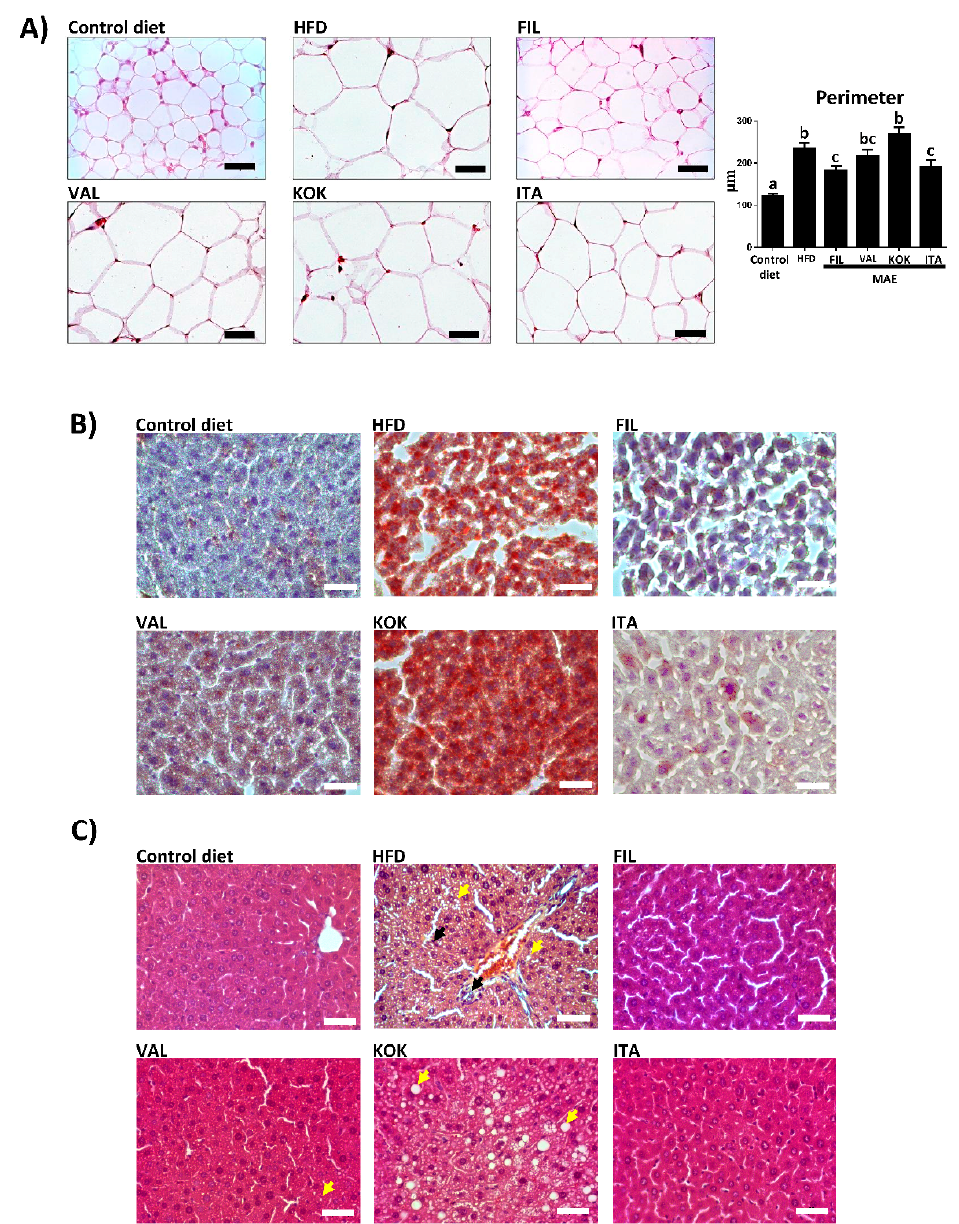
Figure 4. E ff ects of Morus alba genotypes ( Filipina , Valenciana temprana , Kokuso , and Italia ) administration on: ( A ) epididymal adipose tissue, analyzed by hematoxylin and eosin staining (scale bars = 40 µ m) and on perimeter of epididymal adipocyte (Data are expressed as means ± SEM ( n = 10) and groups with di ff erent letters statistically di ff er ( p < 0.05)); ( B ) liver tissue stained with oil red and hematoxylin; and ( C ) liver tissue sections stained with hematoxylin and eosin (yellow arrows indicate the presence of lipid vacuoles in the cytoplasm of hepatocytes and black arrows indicate infiltrations of immune cells) in high fat diet (HFD)-fed mice.